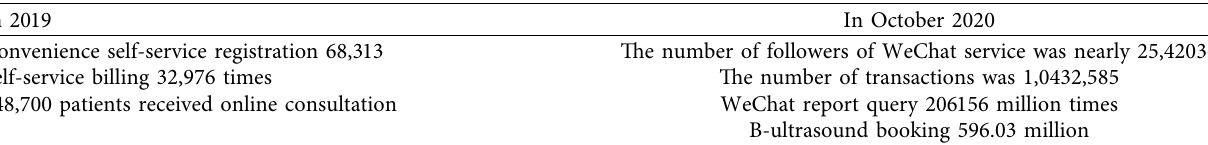
Table 4: WeChat whole process service.